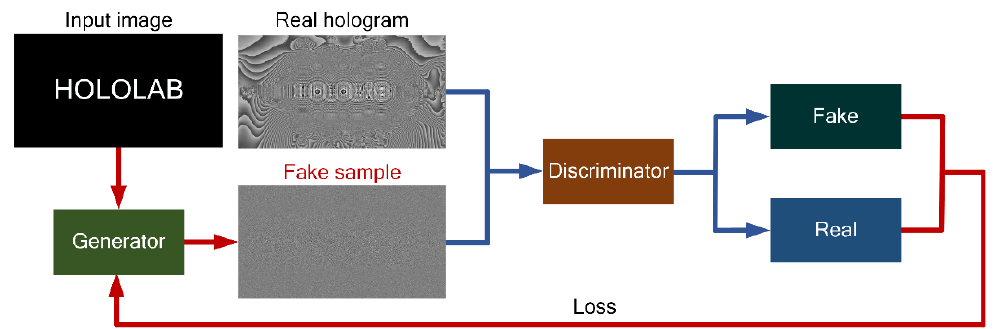
Figure 4. Structure of GAN.